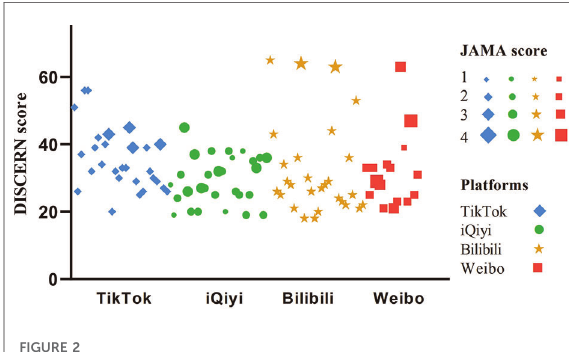
FIGURE 2 Detailed results of DISCERN and JAMA scores of the understudied video.